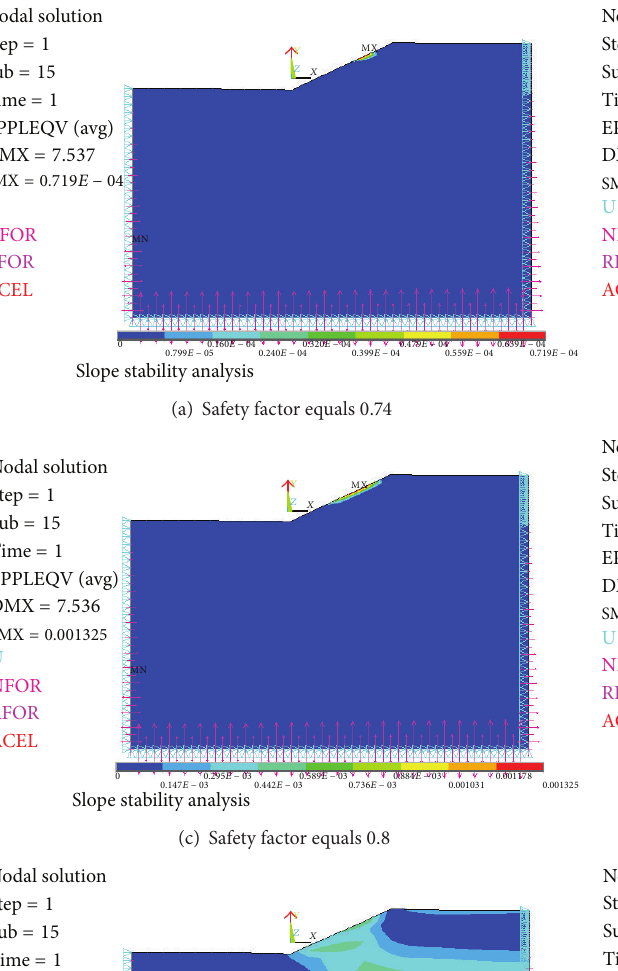
Figure 16. When safety factor is 2.0, von Mises plastic strain runs through from slope toe to top surface in Figure